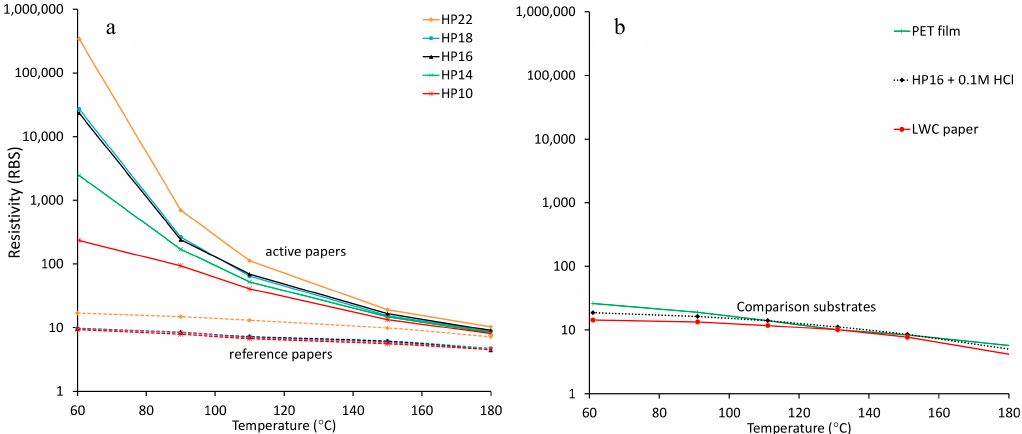
Figure 2. Resistivity of AgNP films showing sintering inhibition on active papers. ( a ) Sintering is inhibited on active papers (solid curves) compared to that on reference papers (dashed curves). ( b ) Pretreating a reference paper with HCl increased the resistivity but the effect was much smaller than the effect on active papers. The resistivities on polyethylene terephthalate (PET) film and lightweight coated (LWC) paper were low compared with that on active papers. Error bars were omitted for visual clarity. RBS = resistivity of bulk silver.